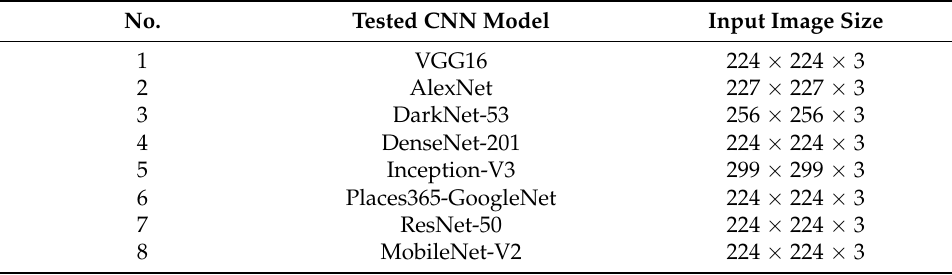
Table 4. The tested fine-tuned CNN models and their input size. No. Tested CNN Model Input Image